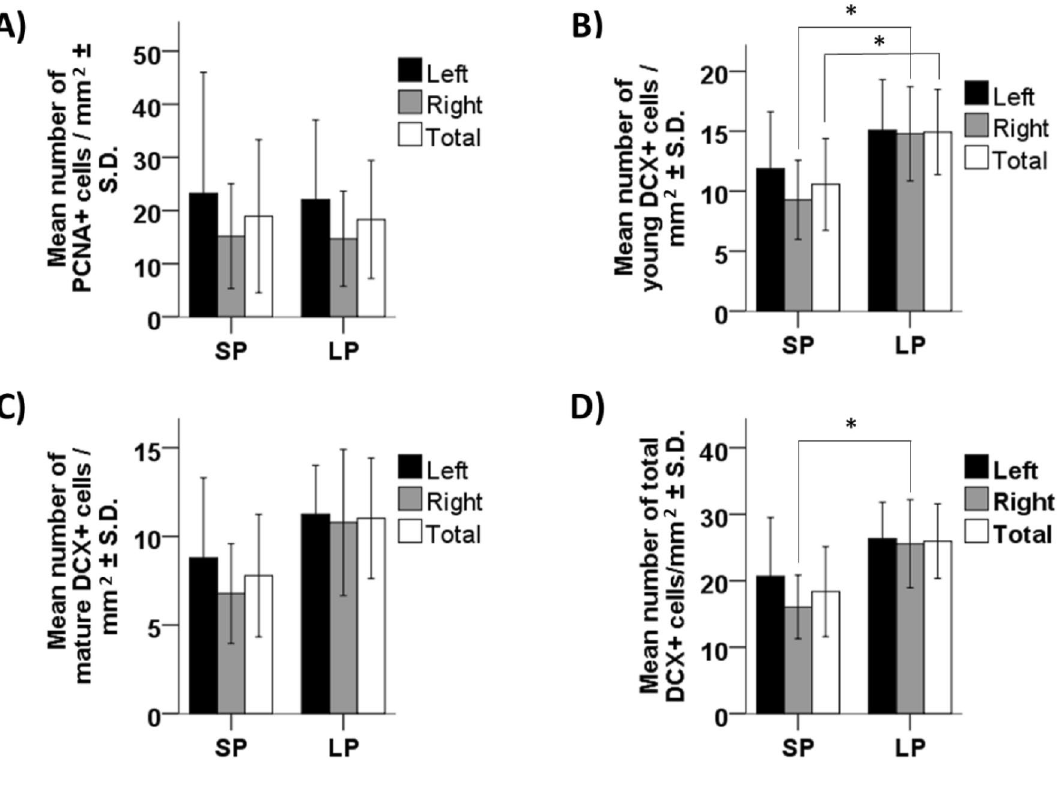
Figure 6. Effect of photoperiod on quail hippocampal neurogenesis. ( A ) Density of PCNA-immunoreactive cells in the hippocampus (left, right, and total) for quail exposed to short (SP) and long (LP) photoperiod. ( B ) Density of DCX young-immunoreactive cells in the hippocampus (left, right, and total), for SP and LP birds. ( C ) Density of mature-immunoreactive DCX cells in the hippocampus (left, right, and total), for SP and LP birds. ( D ) Density of young and mature-immunoreactive DCX cells in the hippocampus (left, right, and total), for SP and LP birds. * p < 0.05. Data are presented as mean ±